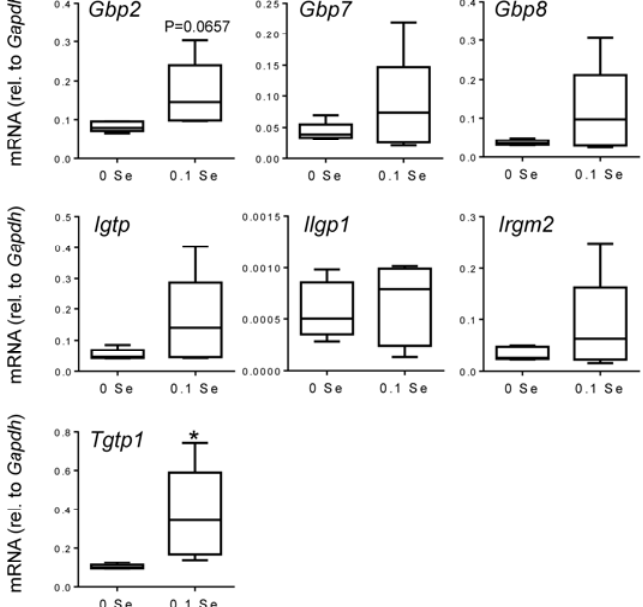
Figure 3. Analysis of interferon- γ -regulated pro-inflammatory mRNA expression in liver by qPCR. Liver mRNA levels for the indicated genes were measured by qPCR for mice fed 0.1 ppm and 0 ppm Se supplemented diets ( n = 5). mRNA levels for each gene were normalized to GAPDH, and graphed with box (median plus 75th and 25th percentile) and whisker (minimum and maximum points) plots. (* p < 0.05 compared to 0 Se).